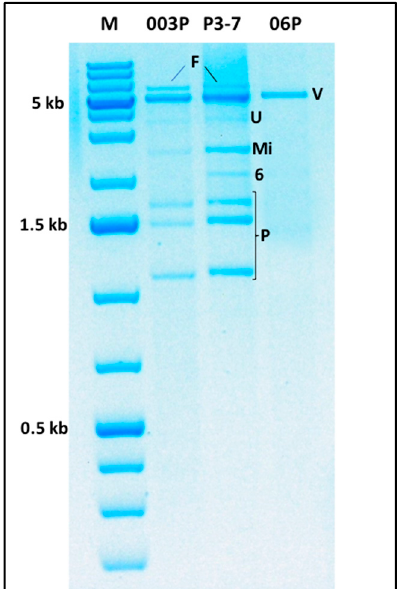
Figure 2. dsRNA banding pattern of the isolates 003P, P3-7, and 06P of Gremmeniella abietina after DNase I and S1 nuclease treatment. M, DNA marker (GeneRuler 1 kb Plus DNA Ladder, 75–20,000 bp, Thermo Scientific); F , dsRNAs corresponding to a putative fusarivirus; V , dsRNA corresponding to